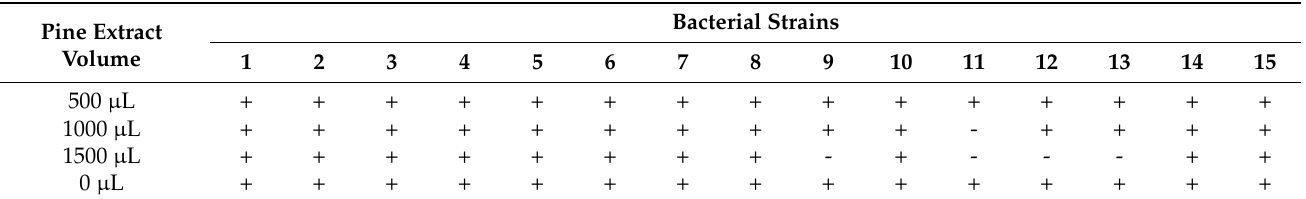
Table 1. The antimicrobial activities of Baltic pine ( Pinus sylvestris ) needle extract against pathogenic opportunistic microorganisms in liquid medium (+ indicates pathogen growth; − indicates that pathogen growth was not observed).